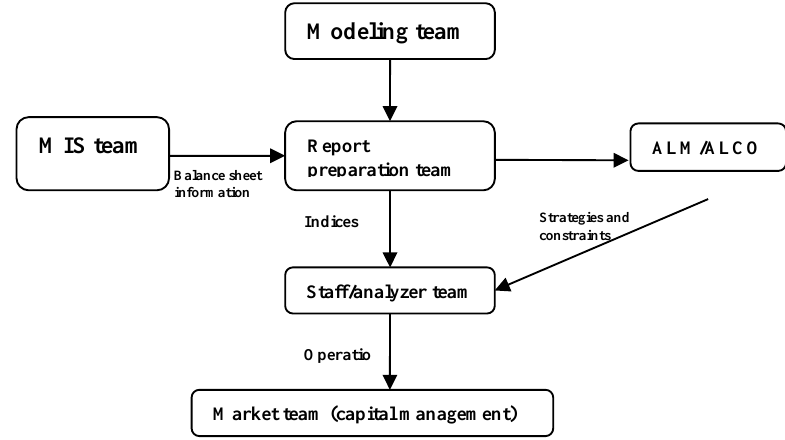
Figure1. Structure of an ALM unit ( Source: Adam, 2007:83-90